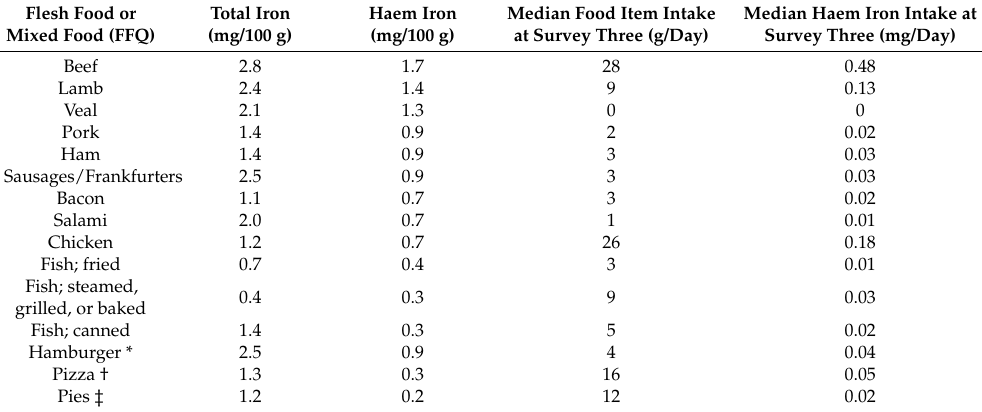
Table 1. Iron present in the Dietary Questionnaire for Epidemiological Studies V2 (DQESv2) Food Frequency Questionnaire (FFQ) flesh foods and mixed foods and the intakes of these food items by Australian Longitudinal Study of Women’s Health (ALSWH) young cohort women in the study sample at survey three